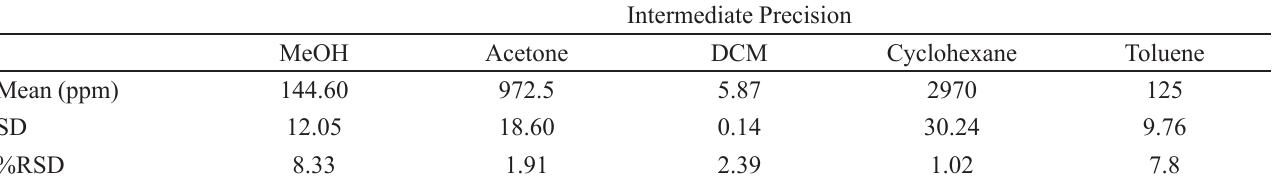
TABLE IV - Intermediate precision data